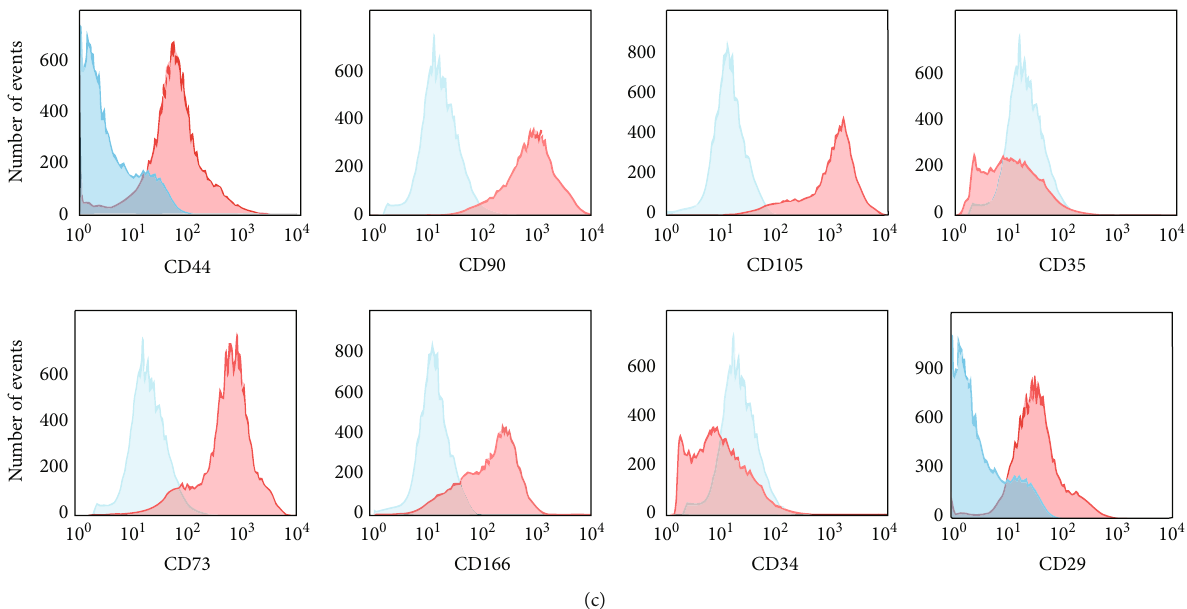
Figure 1: (a) Representative fi gure of the osteogenic, adipogenic, and chondrogenic di ff erentiation potentials of SHED and OOMDSCs. Both SHED and OOMDSCs were capable of osteogenic, adipogenic, and chondrogenic di ff erentiation after culturing in di ff erentiation medium. Osteogenesis is shown by the presence of a mineralized matrix containing calcium hydroxyapatite (red staining when stained with Alizarin Red S), adipogenesis is shown by the formation of lipid vesicles (red staining when stained with Oil Red O), and chondrogenesis is shown by the production of proteoglycans (blue staining when stained with Alcian Blue). Scale bars represent 400 μ m. (b, c) Representative fi gure of the immunophenotypic pro fi les of SHED (b) and OOMDSCs (c). Both SHED and OOMDSCs expressed the mesenchymal stem cell markers CD29, CD44, CD90, CD105, CD73, and CD166 but did not express endothelial (CD31) or hematopoietic (CD34) markers on the cell surface. Histograms demonstrate the binding of conjugated antibodies (in red) and isotype controls (in blue) to surface antigens. Table 1: Average expression of mesenchymal, hematopoietic, and endothelial stem cell markers. Cell surface